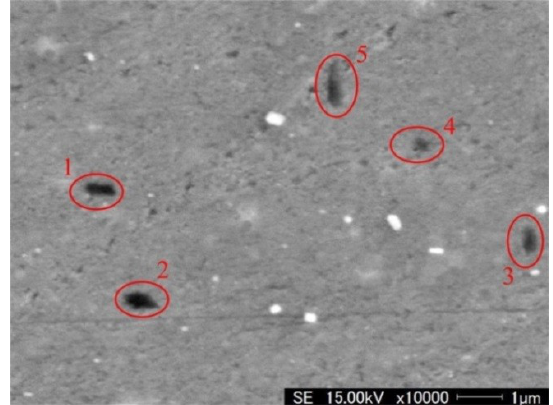
Figure 5. Micrograph of the 6061-T6 aluminum alloy sample heated by conduction heating (1, 2, 3, 4 and 5 indicate the precipitate’s serial number).